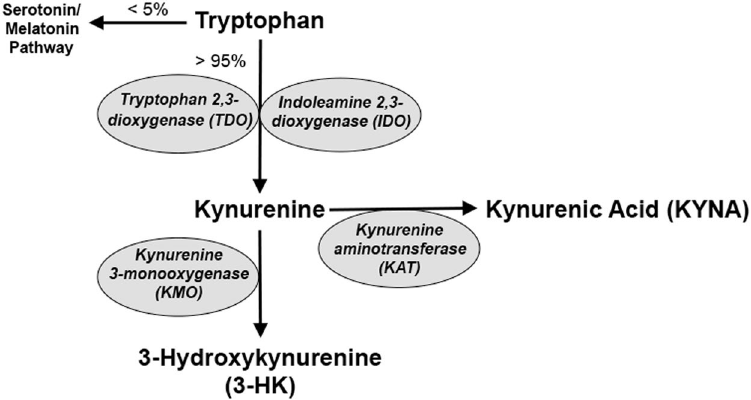
Figure 1. Schematic representation of the kynurenine pathway (KP) of tryptophan